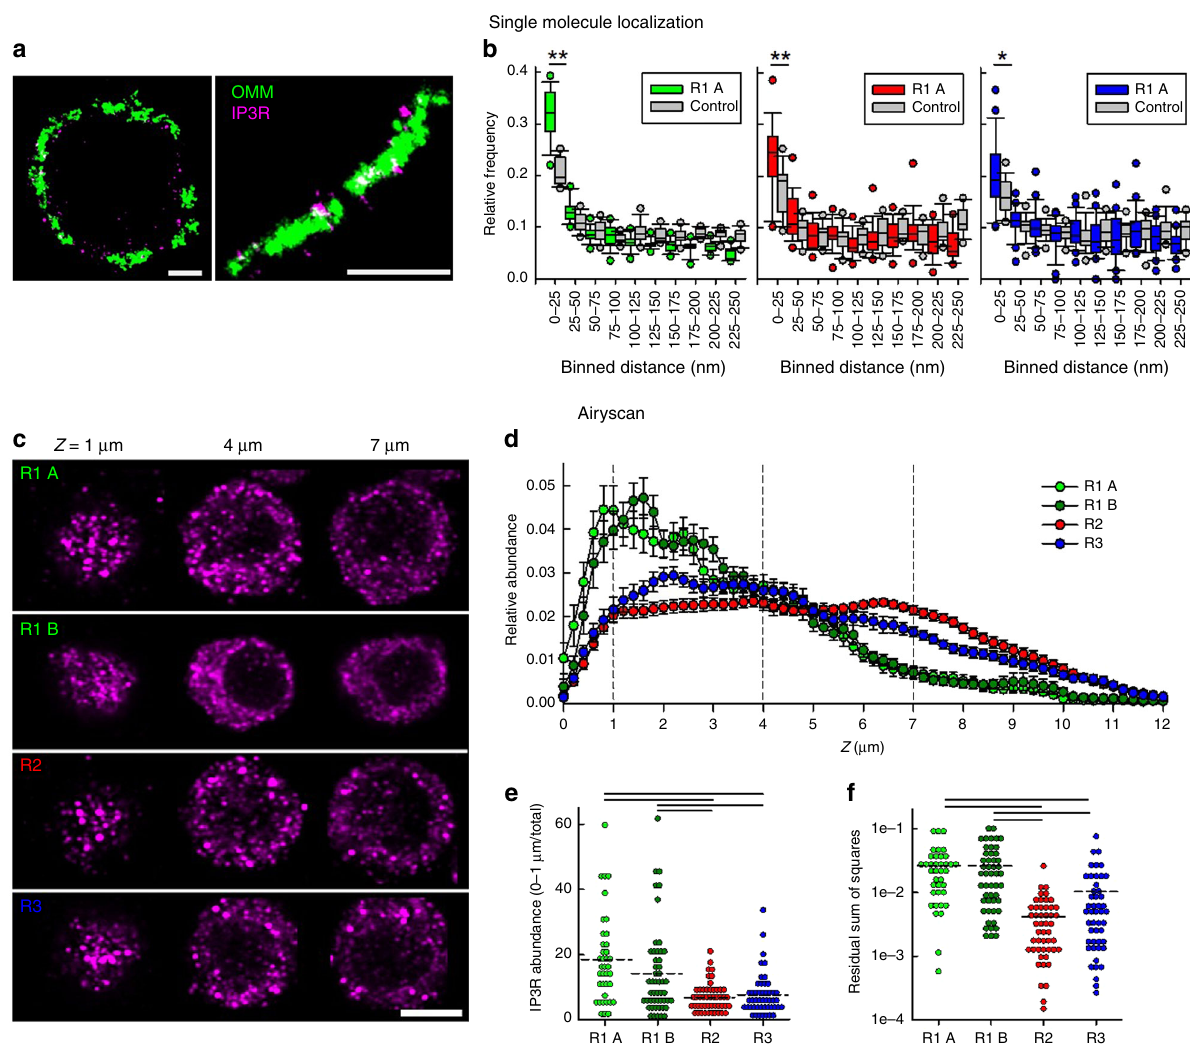
Fig. 3 Each IP3R isoform forms clusters near mitochondria, but their subcellular distributions vary. a OMM (Tom20) and IP3Rs visualized by Vutara 352 STORM based super-resolution (single-molecule imaging) system. 2D projection of Z = 200 nm thickness is shown. Bars = 2 µ m. b Shortest distances between IP3R and OMM clusters were measured in 3D. Relative frequencies of minimum distances are shown within 0 – 250 nM (median line, box: 25 – 75%, error bars 10 – 90% and individual outliers as dots N = 15, 18, 24 cells, respectively, from three independent experiments). For reference, the same measurements were performed using mock randomly generated clusters in place of the IP3R clusters (control) ( N = 14, 13, 19, respectively). * p < 0.05, ** p < 0.01, unpaired Student ’ s t -test. c Anti-FLAG immuno fl uorescence in IP3R-FLAG expressing cells in Z sections at 1, 4, and 7 µ m. Scale bar = 5 µ m. d Relative abundance of IP3Rs in R1 A ( N = 38), R1 B ( N = 50), R2 ( N = 49), and R3 ( N = 48) cells plotted against the Z -axis. e Cumulative abundance of IP3Rs in the 0 – 1 µ m Z sections of each cells (mean, dashed lines from four independent experiments). Black lines indicate p < 0.05 with one- way ANOVA with post-hoc Dunn ’ s method. f Residual sum of squares for mitochondria and IP3Rs (Mt-IP3R). Cellular averages (dashed lines) are compared. Black lines represent p < 0.05 with one-way ANOVA with post-hoc Dunn ’ s method. Source data are provided for panels B , d , e , f as a Source Data fi